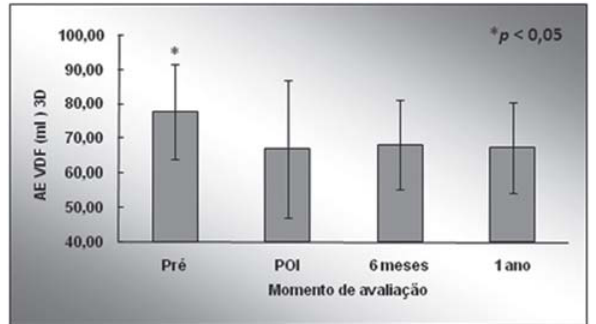
Fig. 6. Evolução da fração de ejeção do átrio esquerdo (FEAE) durante o estudo. Observamos aumento significativo na FEAE entre o momento 6 meses e POI (pós-operatório imediato). Esse aumento permaneceu estável durante o estudo. Valores = média ± desvio-padrão. * P < 0,05 em relação ao POI